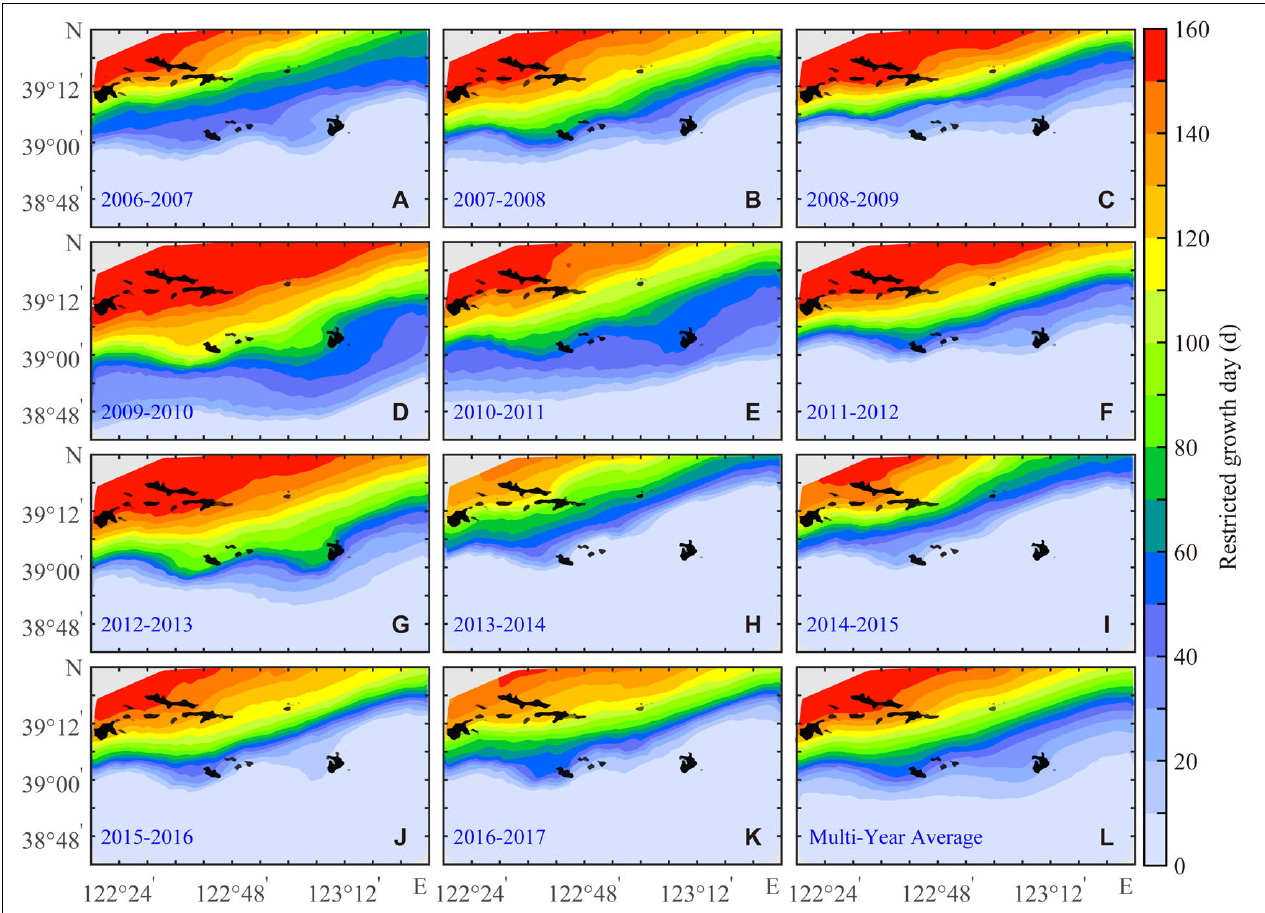
FIGURE 5 | Annual (A–K) and the multiyear average (L) of restricted growth days for the Yesso scallop ( P. yessoensis ) in the Changhai sea area, China, from December 1, 2006 to November 30, 2017.